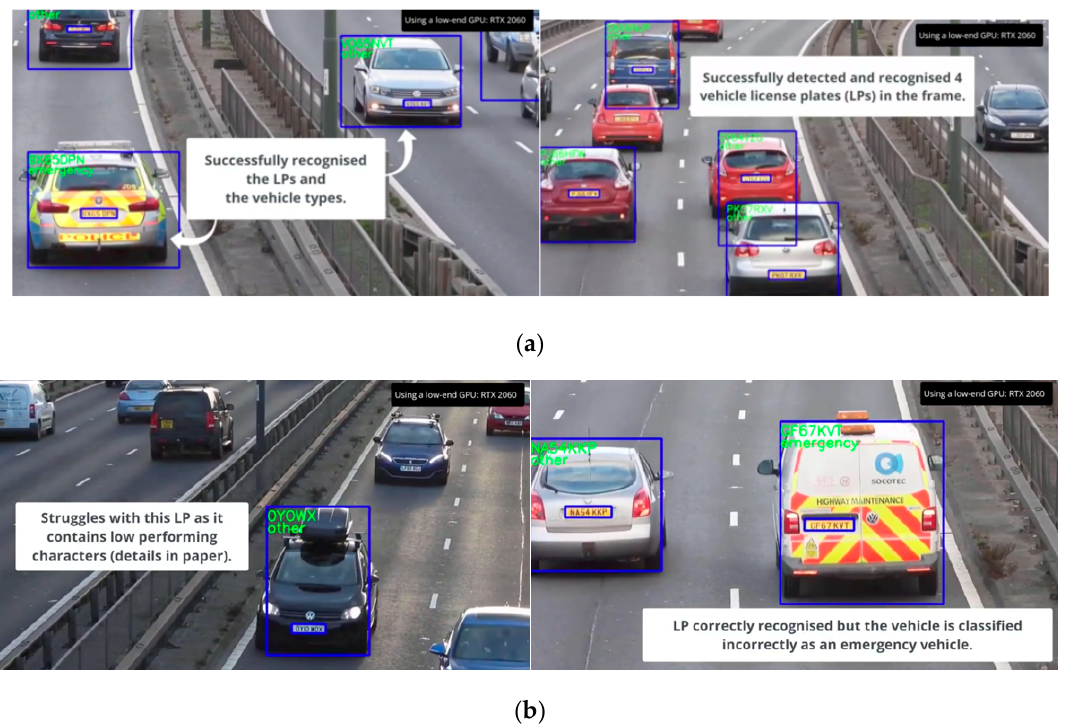
Figure 6. ( a ) Examples of successful detection of LPs and vehicle types; ( b ) Examples of images in which LP detection or classification failed.